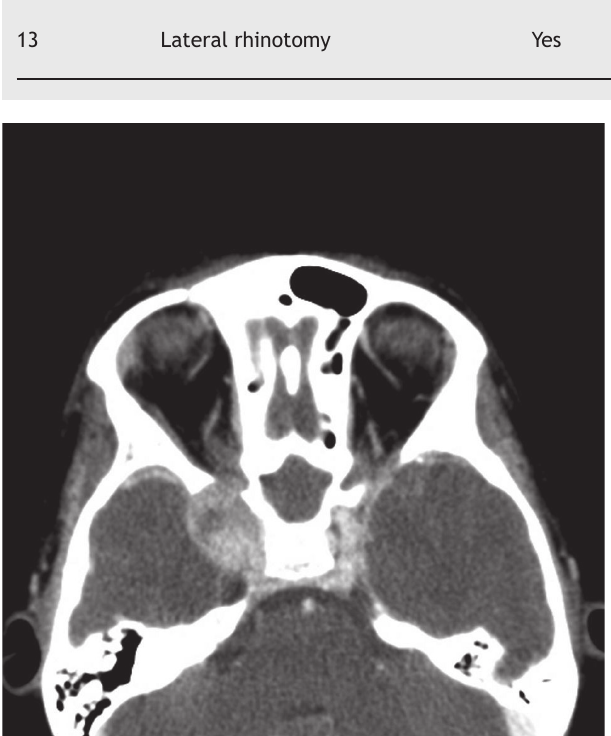
Figure 1 Computed tomography scan (axial view) of a juvenile angiofibroma extending into the right cavernous sinus.